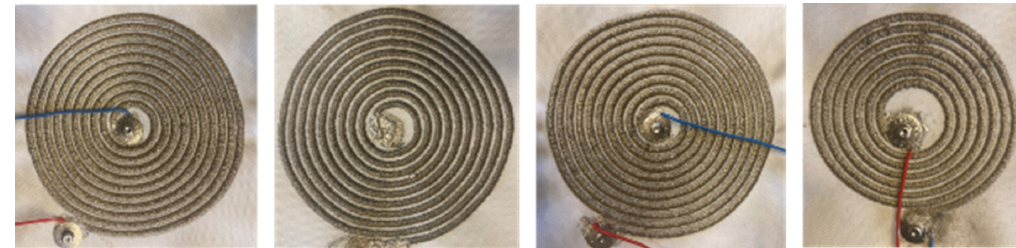
Figure 1. Embroidered coils with Shieldex yarn (from left to right) Z175, Z275, Z375, Z455.